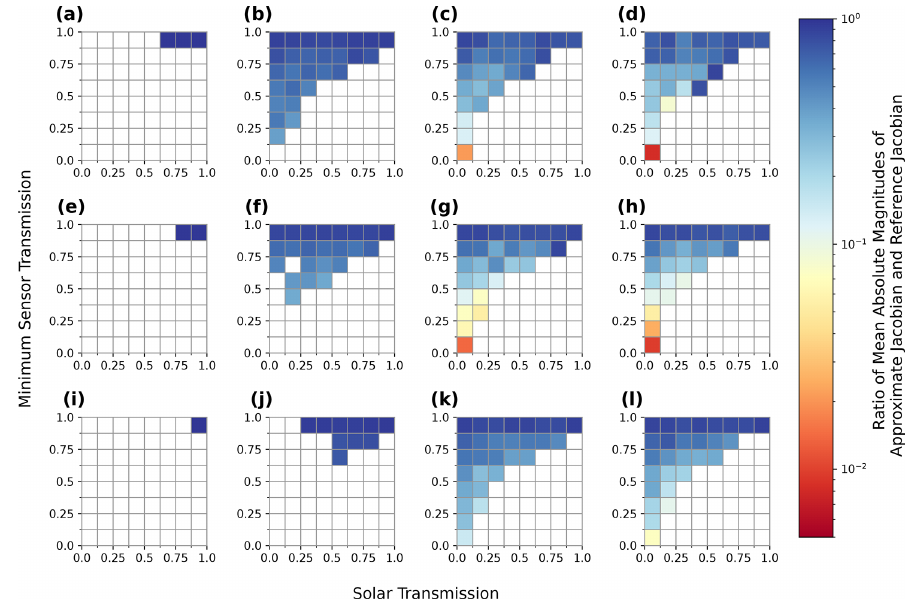
Figure 12. The ratio of the mean absolute magnitude of the approximate Jacobian to the mean absolute magnitude of the finite-difference Jacobian in each bin of solar and minimum sensor delta-M transmission for 3D Gaussian clouds with conservative scattering over a black surface. This figure is the same as Figs. 9 and 11. As in Fig. 9, each column corresponds to a base state, with maximum cloud optical depth from 0.1, 5.0, 40.0, and 100.0, increasing from left to right. Each row corresponds to a base state with different phase function and angular resolution, with isotropic phase function (a, b, c, d) , Mie phase function with high angular resolution (e, f, g, h) , and Mie phase function with low angular resolution (i, j, k, l)